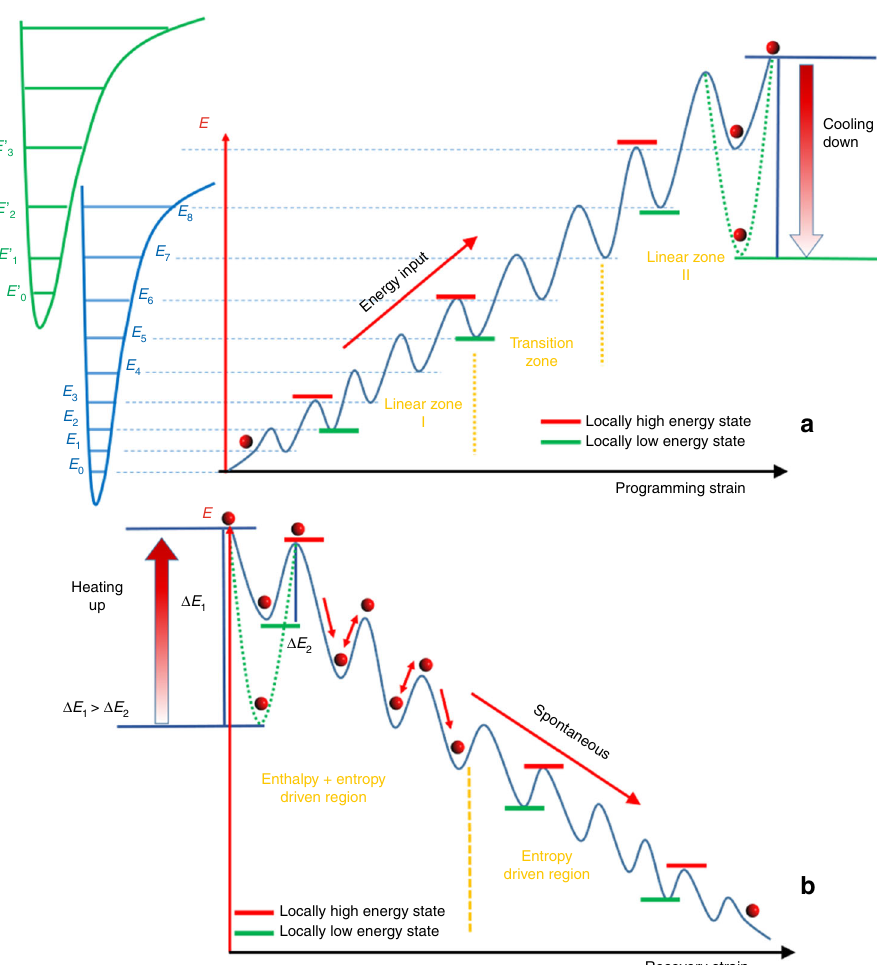
Fig. 4 The multiple energy well model for amorphous thermoset shape memory polymers. a Programming. During programming at temperature above the glass transition zone, the network climbs up an energy hill with local energy well (or dip) (blue line) for local, meta-stale states. At the end of programming (after cooling and unloading), a deep energy well (dashed green line) is formed and thus the network is in a locked, non-equilibrium state. b Recovery. Energy input, such as heating, is needed to drive the cold energy well (dashed green line) back to the hot energy well (solid blue line) and help the CSBs (red circles) jump out of the fi nal energy well, roll down the energy hill, and achieve shape recovery without external constraint, or stress recovery with external